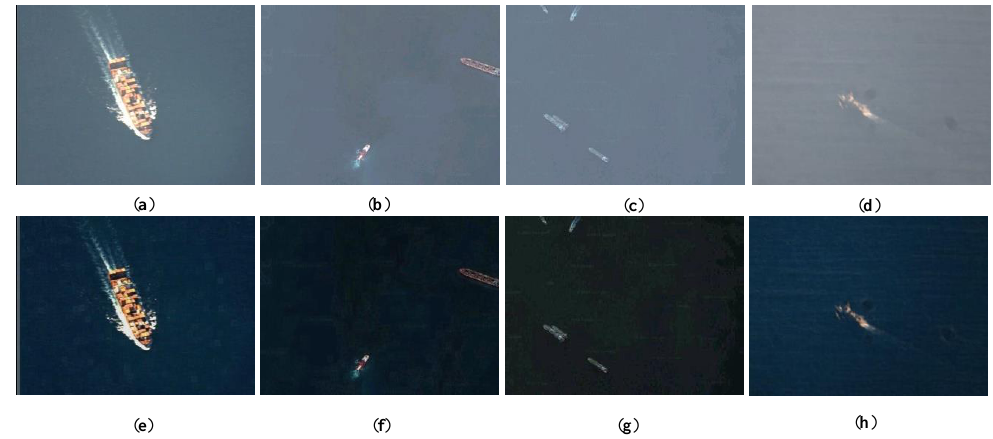
Figure 6. Atmospheric correction effect of satellite remote sensing images and aerial remote sensing images. ( a – d ) Original image. ( e – h ) Ship images after atmospheric correction. ( a , d ) Aerial remote sensing images. ( e , h ) Atmospheric correction effects of aerial remote sensing images. ( b , c ) Satellite remote sensing images. ( e , h ) Atmospheric correction effects of satellite remote sensing images.